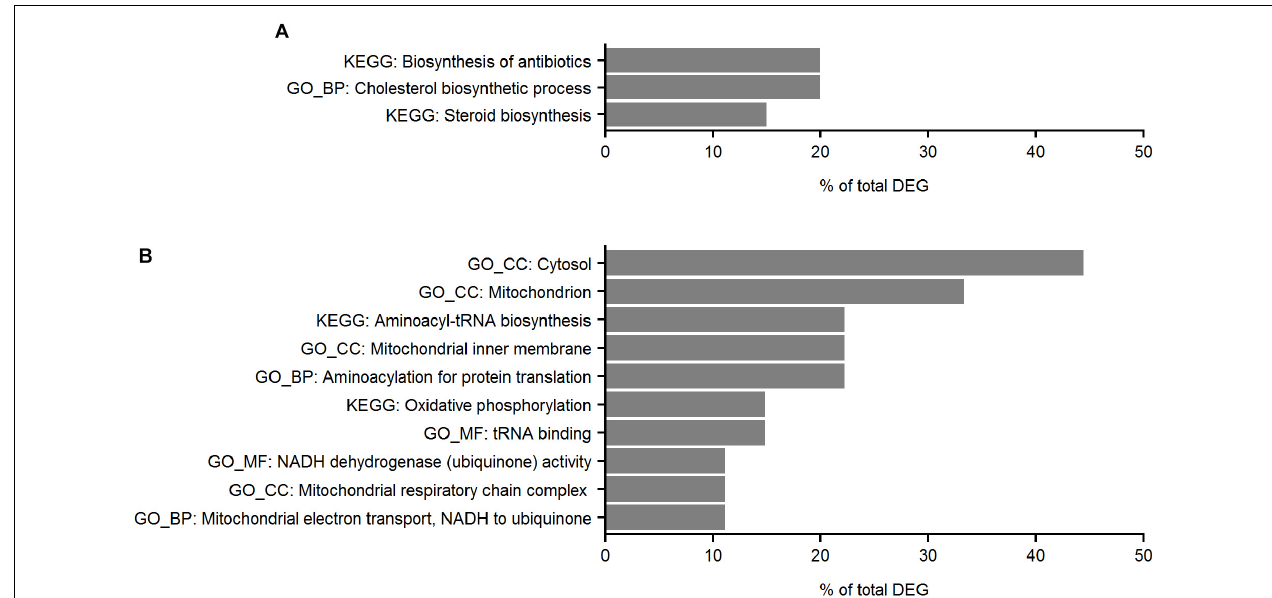
FIGURE 11 | Functional analysis of differentially expressed genes (DEG) enriched in the Segment 1 of wrasse intestine. (A) Moist diet; (B) dry diet. The graph shows the percentages of total DEG present in each of the KEGG and Gene Ontology (GO) categories. For the GOs, biological process (BP), cellular compartment (CC) and molecular function (MF) of the genes were considered in the analysis. For the enrichment analysis FDR < 5% was used as the significant threshold.